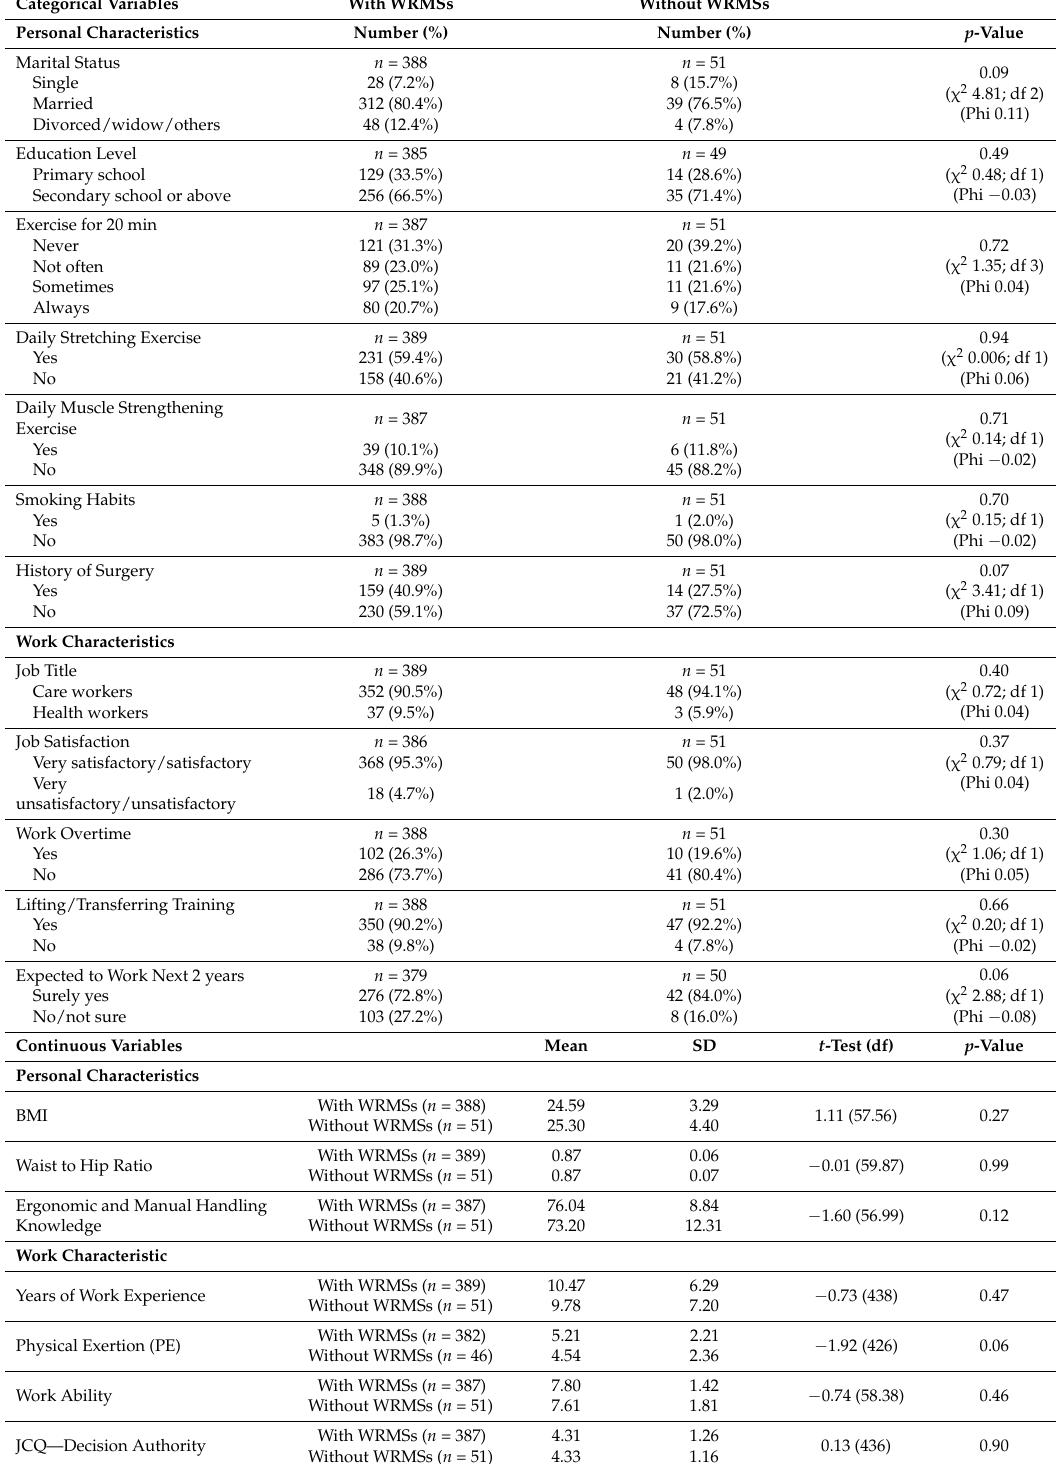
Table A1. Factors not significantly associated with WRMSs among NAs measured at the time of survey: A bivariate analysis (N =